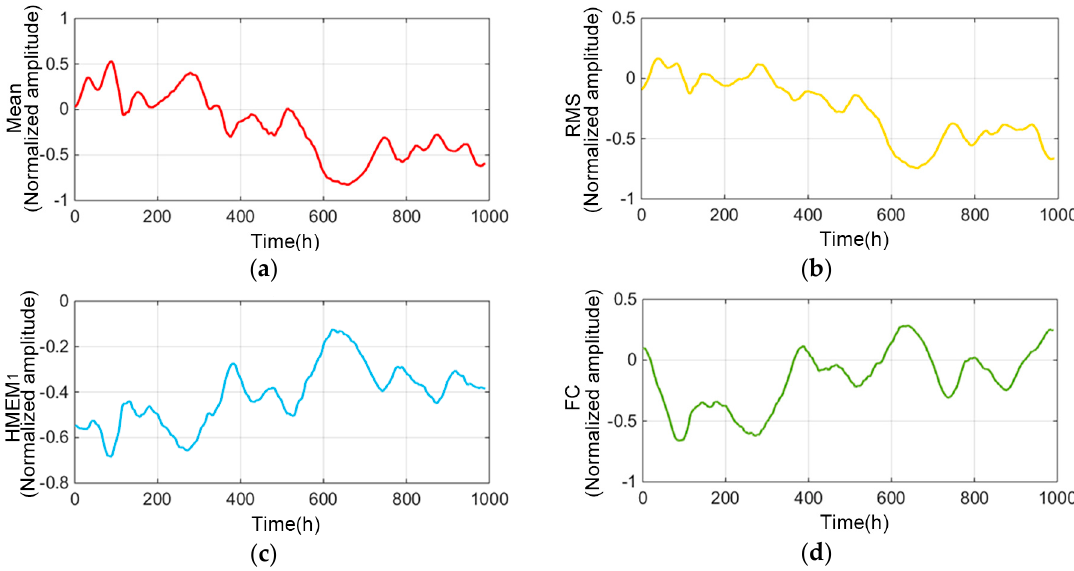
Figure 11. Parts of trend characteristics: ( a ) Mean, ( b ) RMS, ( c ) HMEM 1 , ( d ) FC.